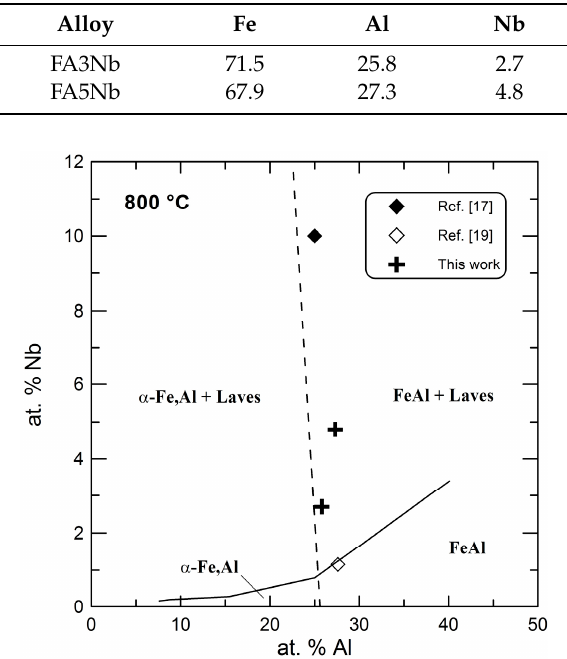
Figure 1. Detail of the isothermal section of the Fe-Al-Nb system at 800 °C according to Palm [20].